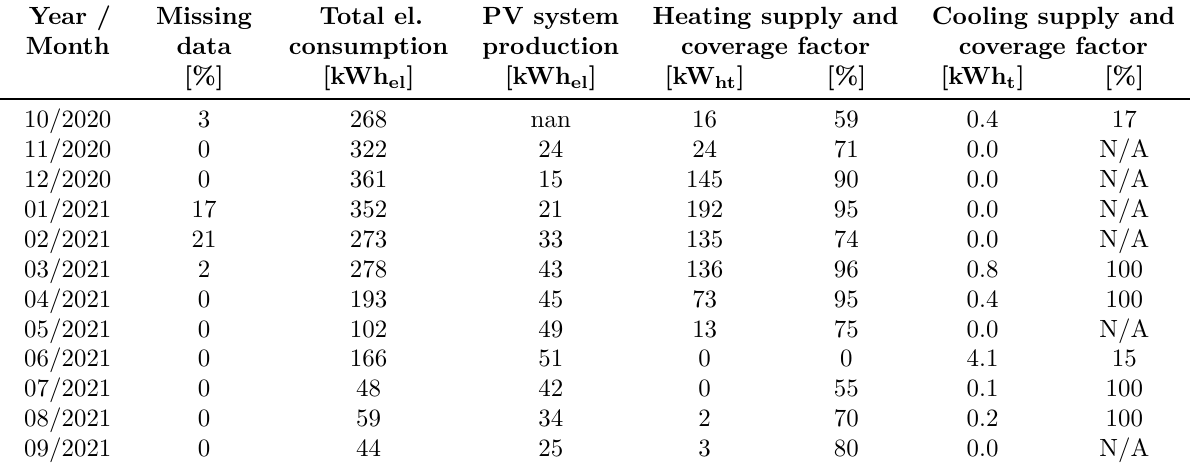
Table 2. Energy performance of the façade module: monthly